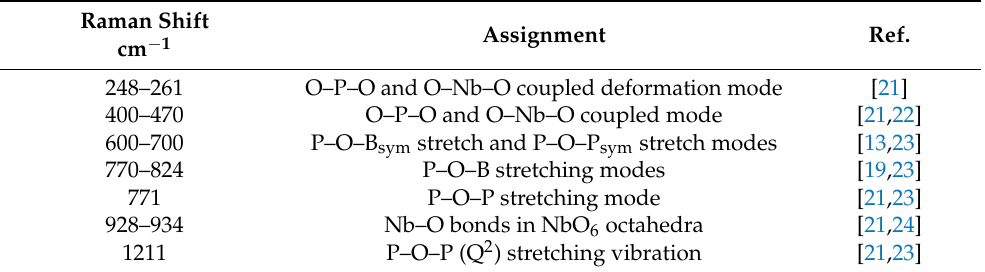
Figure 4. Raman spectra of the glass series (100 − x)[0.4Na 2 O-0.2Nb 2 O 5 -0.4P 2 O 5 ]-xB 2 O 3 . Table 2. Raman bands and corresponding assignment of the (100 − x)[0.4Na 2 O-0.2Nb 2 O 5 -0.4P 2 O 5 ]- xB 2 O 3 glasses.